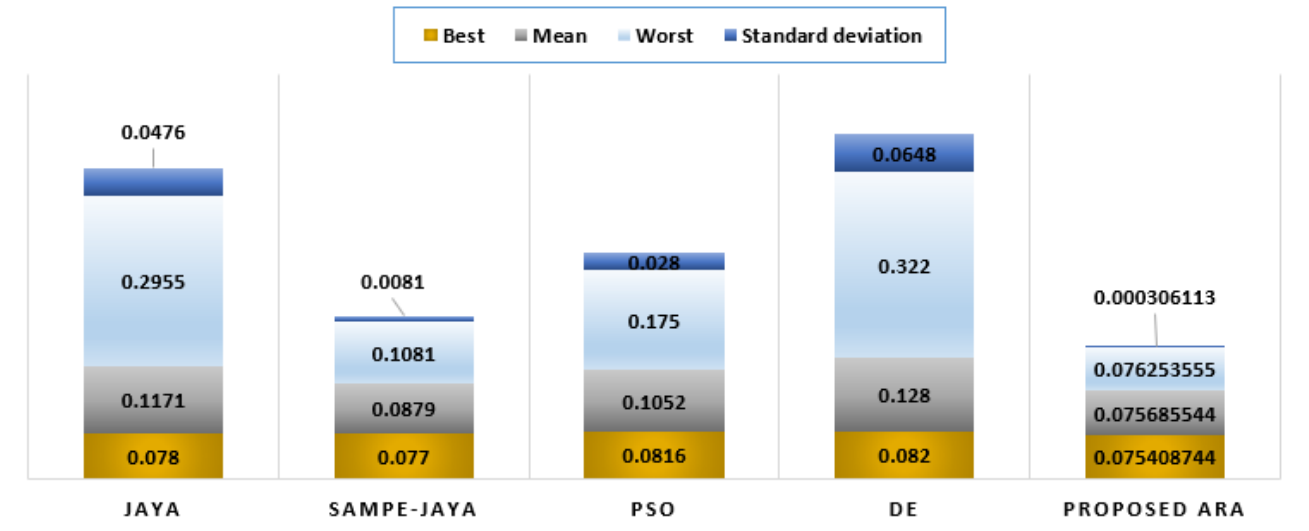
Figure 7. Statistical indices for SAMPE-JAYA, JAYA, DE, PSO and the proposed ARA under case study 2. Table 4. Simulation results under Case Study 3.